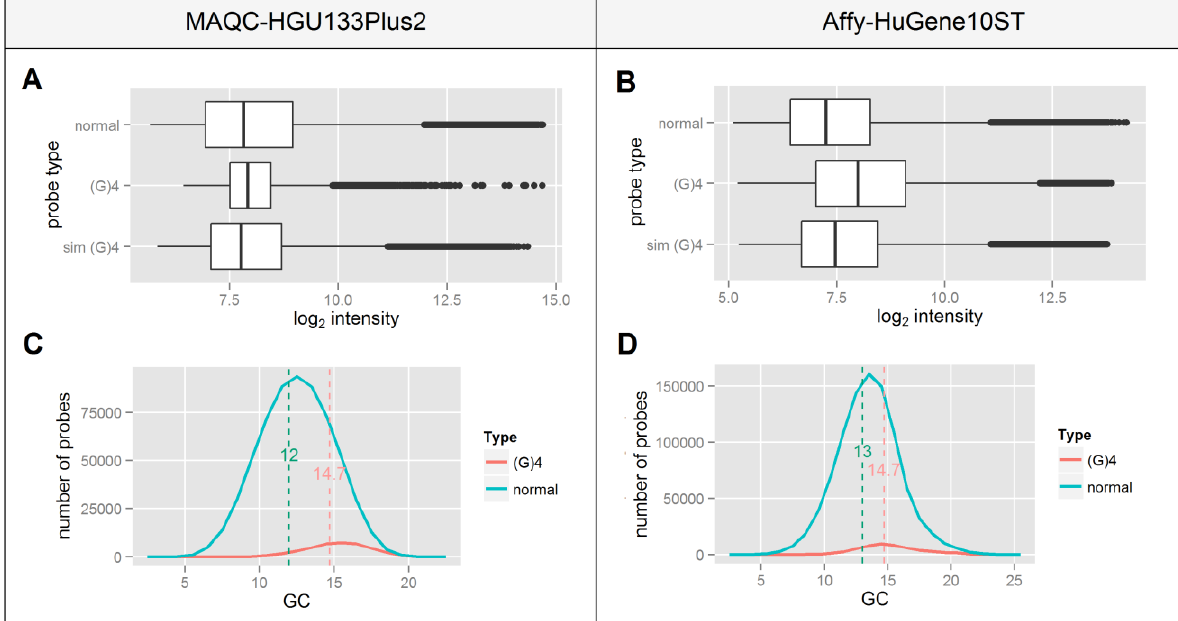
Figure 3. Statistics of probes that contain (G) motif for both MAQC and Affy datasets 4 ( A , B ) signal intensity boxplots of normal probes, probes that contain a (G) motif and a 4 subset of ―normal‖ probes that have the same GC content distribution as the (G) 4 probes—―sim (G) ‖ ( C , D ) GC content distribution of normal and (G) probes with medians 4 4 of both distributions marked with a dashed